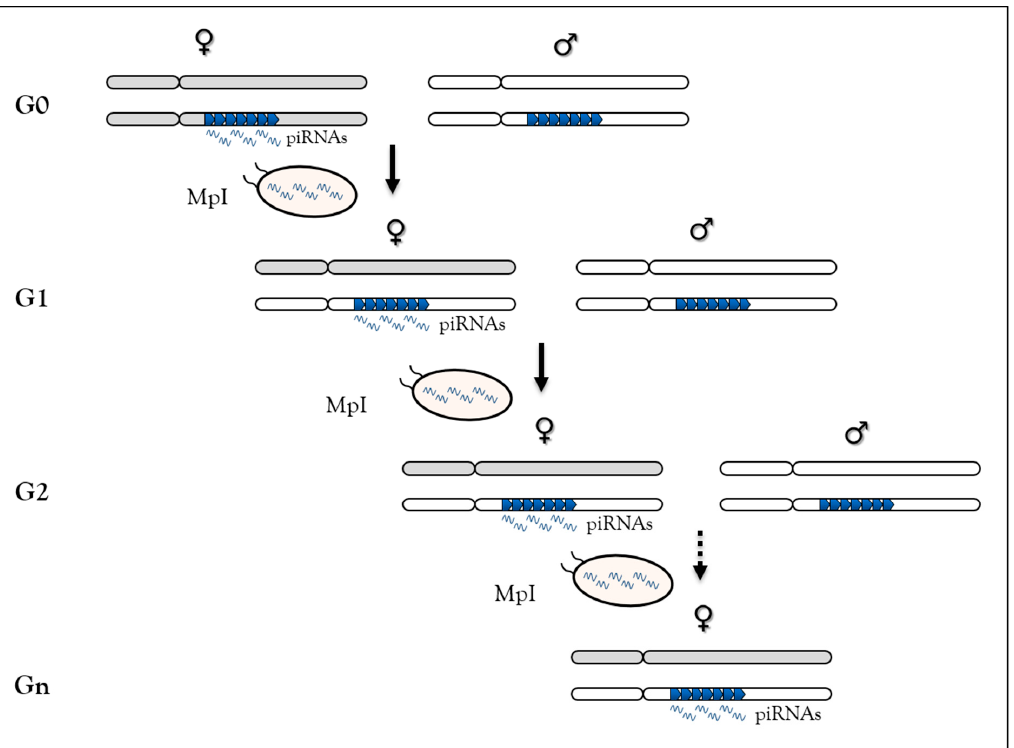
Figure 2. The paramutation process in Drosophila melanogaster relies on maternal piRNA inheritance. At G0, females (grey chromosomes) carrying the BX2 clusters made of repeated P-lacZ-white transgenes (blue arrowheads) producing piRNAs are crossed to males (white chromosomes) carrying the same cluster not producing piRNA. At G1, maternal piRNA deposition in the embryo leads to activation of piRNA production from the paternal cluster allele. The newly activated cluster can activate the paternally-inherited inactive cluster in G2 due to maternal piRNA inheritance (MpI). Then, this process of activation leads to stable piRNAs production across